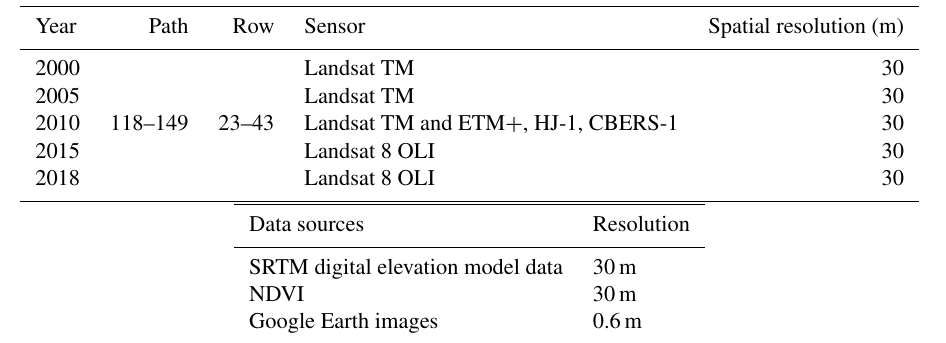
Figure 1. The technological flowchart of generating the CLUD-Urban product. Table 1. The multitemporal data series used in this